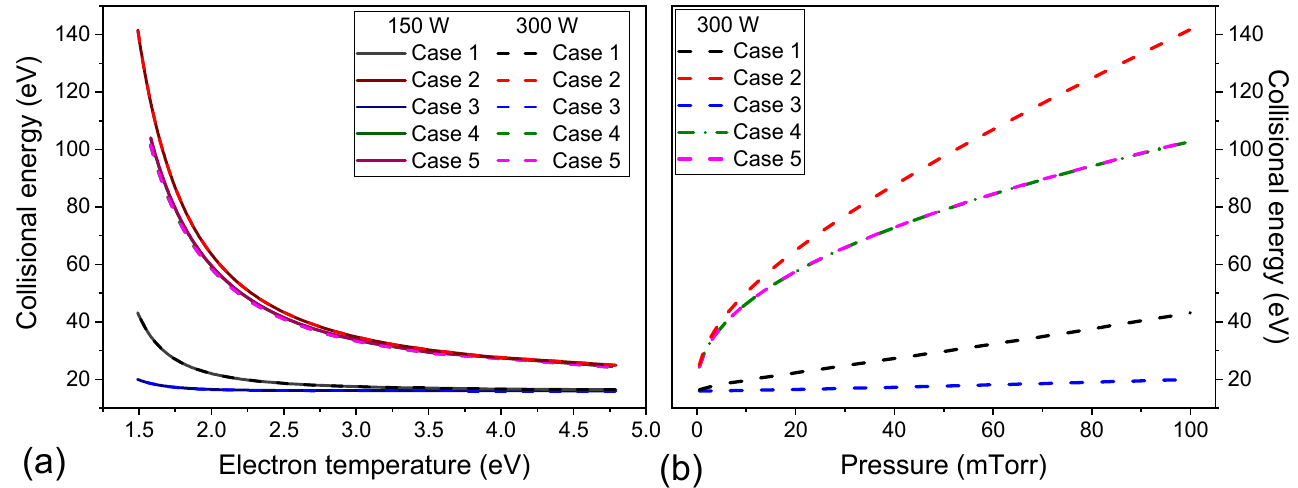
Figure 3. The collisional energy of all investigated cases as a function of electron temperature at absorbed powers of 150 W and 300 W for a gas pressure of 0.5–100 mTorr ( a ), and as a function of gas pressure at 300 W ( b ).